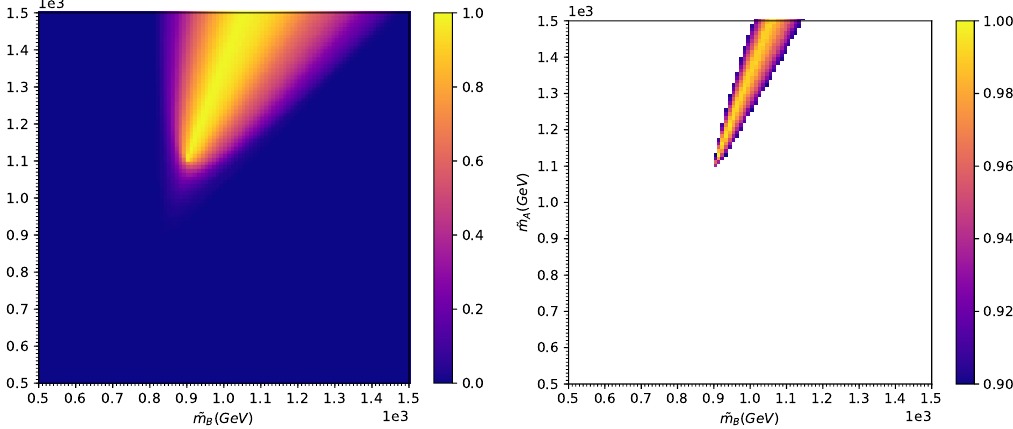
Figure 10 . Solvability heat maps as in (cid:12)gure 7, except here ~ m not independent, but obey the relation